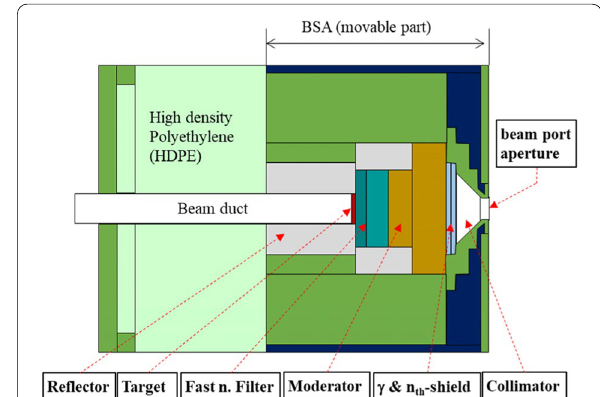
Fig. 15 Cross‑sectional view of the DM A‑BNCT BSA and collimator